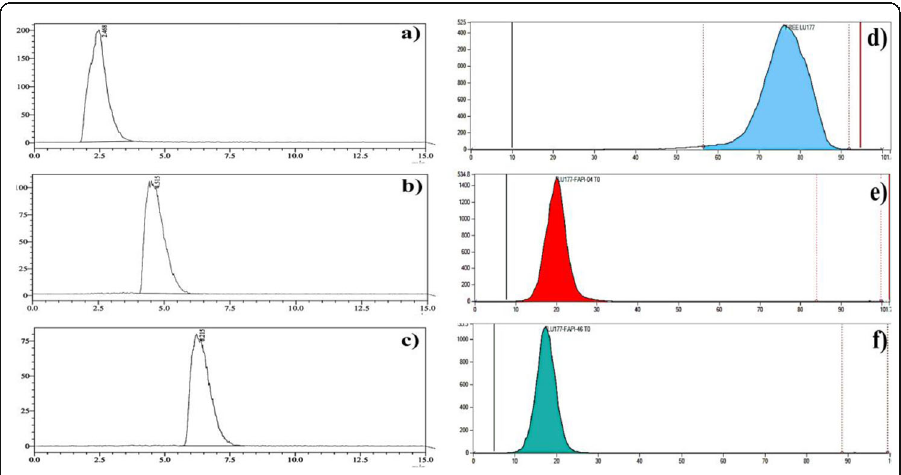
Fig. 5 R-HPLC chromatograms of ( a ) Free [ 177 Lu] Lu, ( b ) [ 177 Lu]Lu-FAPI-04, ( c ) [ 177 Lu]Lu-FAPI-46. Free [ 177 Lu] Lu RT: 2 – 3 min., [ 177 Lu]Lu-FAPI-04 RT: 4 – 5 min., [ 177 Lu]Lu-FAPI-46 RT: 6 – 7 min. (Method parameters are the same as depicted in Fig. 2). R-TLC chromatograms of ( d ) Free [ 177 Lu] Lu, ( e ) [ 177 Lu]Lu-FAPI-04, ( f ) [ 177 Lu]Lu- FAPI-46. TLC plate: ITLC SG, mobile phase: 0.05 M Citrate buffer pH 4, Free [ 177 Lu] Lu RF: 0.8 – 1.0, [ 177 Lu]Lu- FAPI-04 & [ 177 Lu]Lu-FAPI-46. RF: 0.0 –